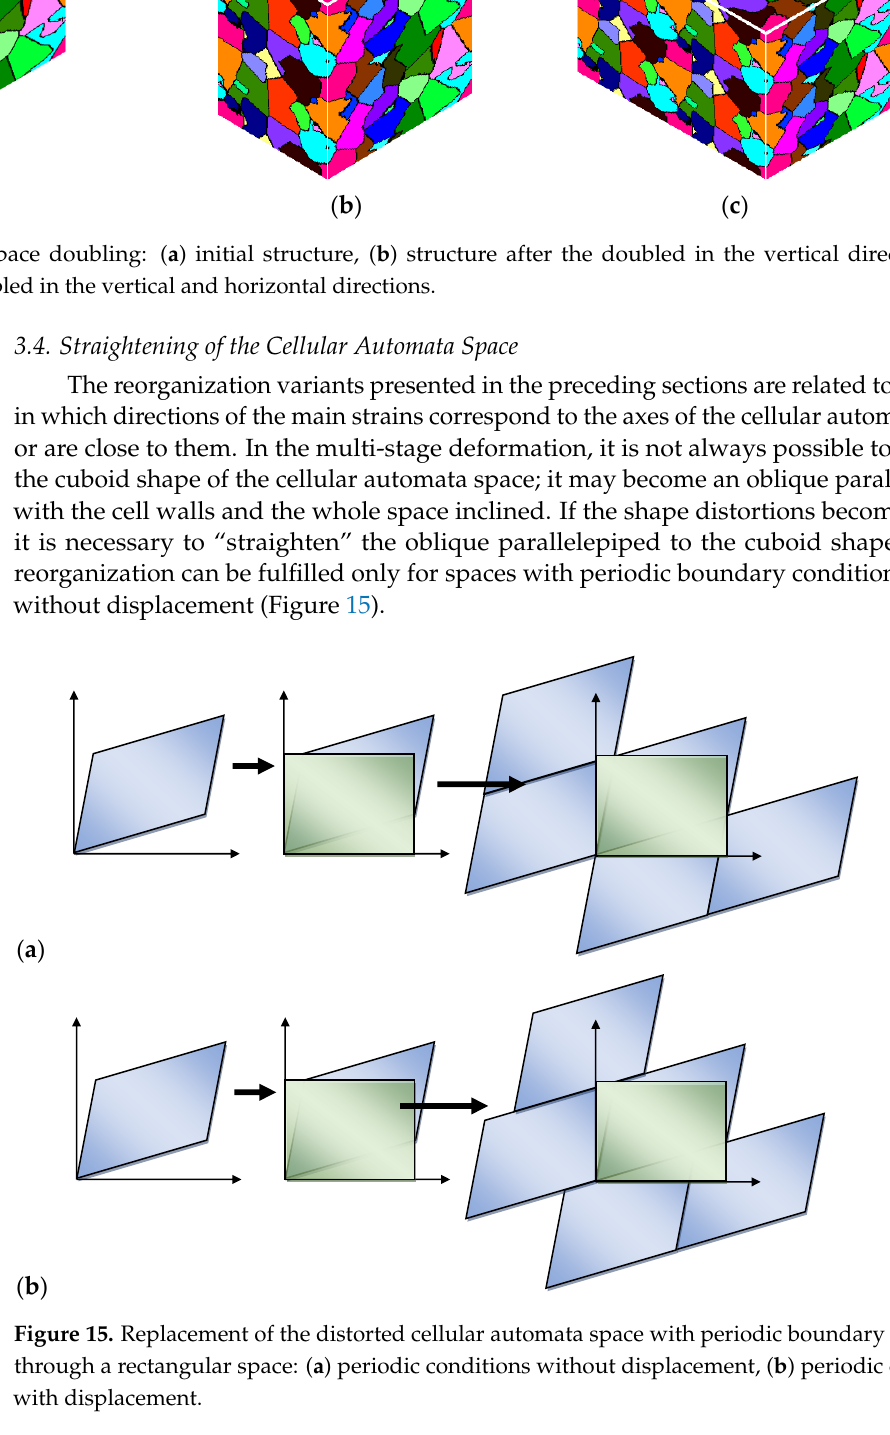
Figure 13. Doubling of space with periodic boundary conditions: ( a ) without displacement, ( b ) with displacement.